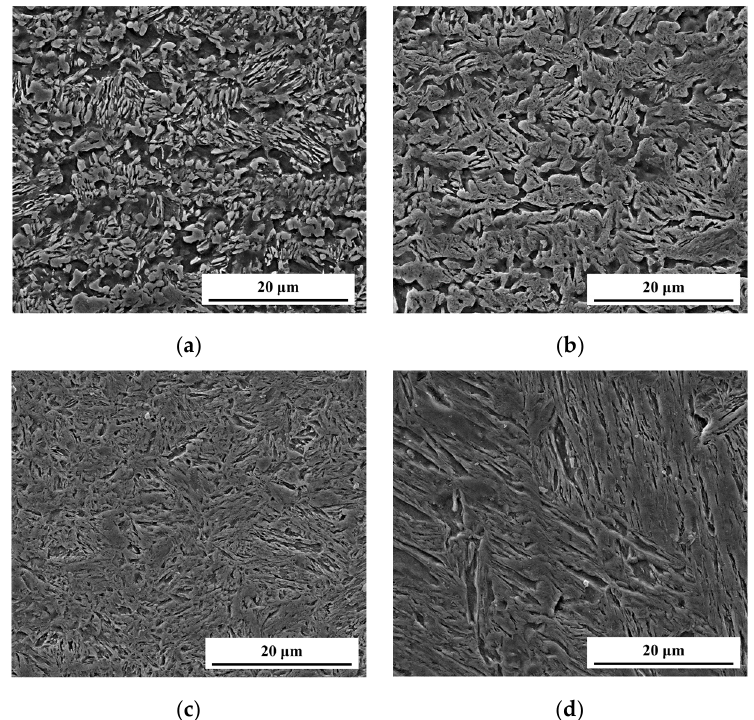
Figure 5. Microstructure of ( a ) base metal (BM), ( b ) sub-critical heat affected zone (SCHAZ), ( c ) upper-critical heat affected zone (UCHAZ), and ( d ) fusion zone (FZ).